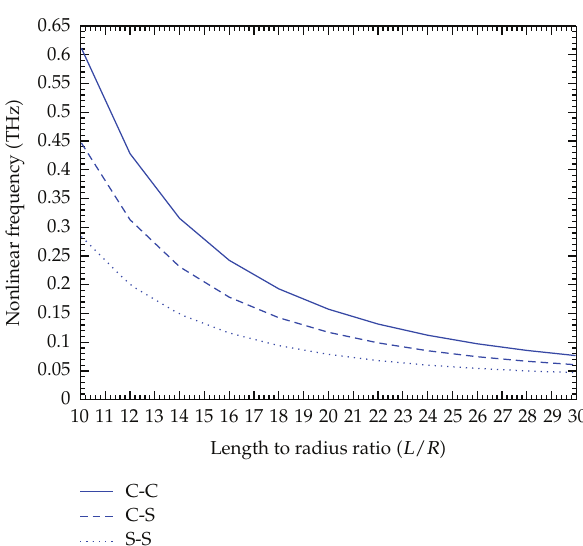
Figure 6: Fundamental nonlinear frequency against length to the outermost diameter ratio of a TWNT under di ff erent boundary conditions (cid:3) k (cid:8) 10 7 N/m 2 and X (cid:8) 2 (cid:4) .